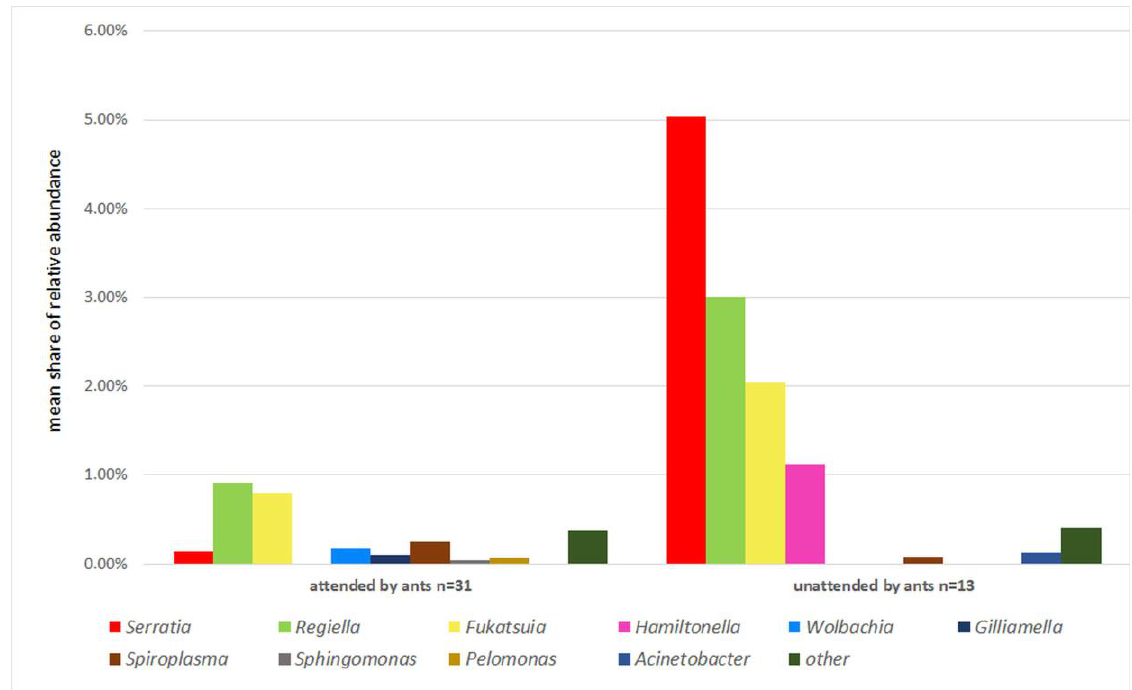
Figure 3. Mean shares of particular secondary symbionts in reference to ant attendance.